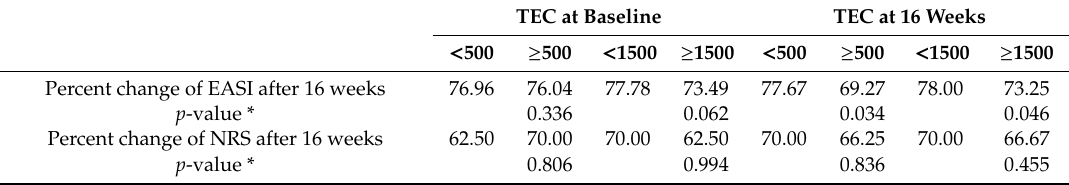
Table 6. The di ff erence of e ffi cacy, according to TEC. High TEC at baseline, showed a lower change in POEM after 16 weeks. High TEC at 16 weeks showed a lower change in EASI and POEM after 16